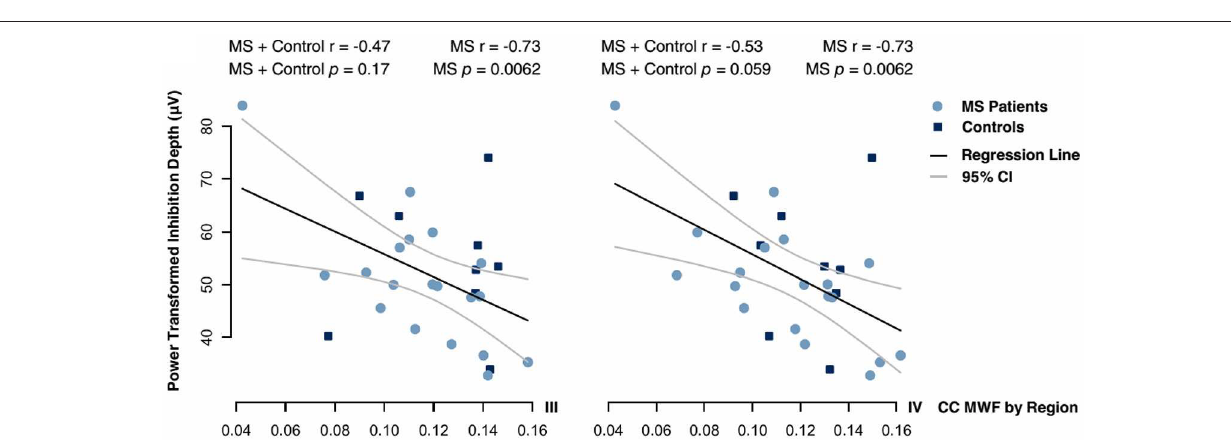
FIGURE 7 | Correlations between inhibition depth with Box-Cox power transform and MWF in regions III and IV of the CC. Data were fitted by Pearson regression. Product-moment correlation coefficients and p -values adjusted for multiple comparisons by a Holm-Bonferroni correction are